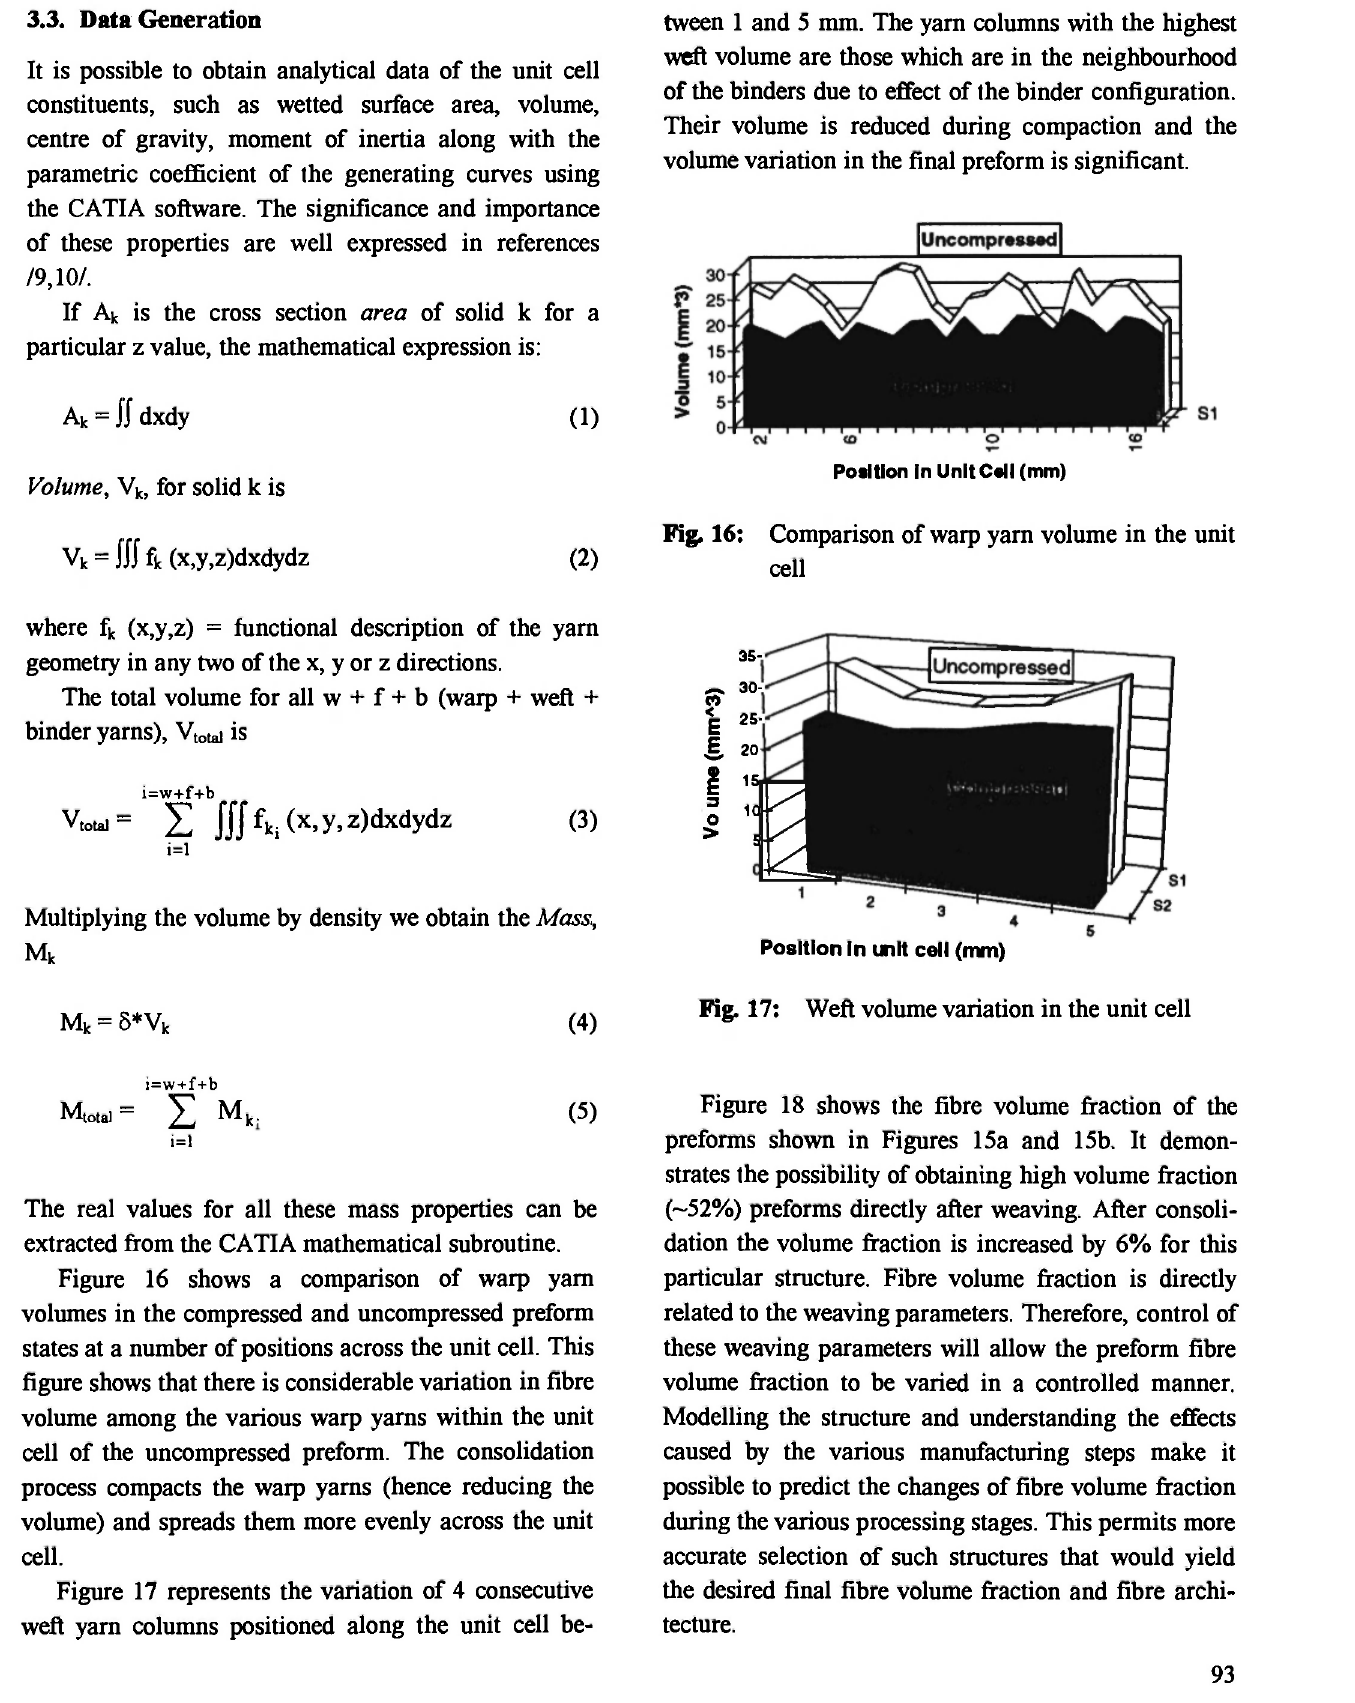
Fig. 16: Comparison of warp yarn volume in the unit